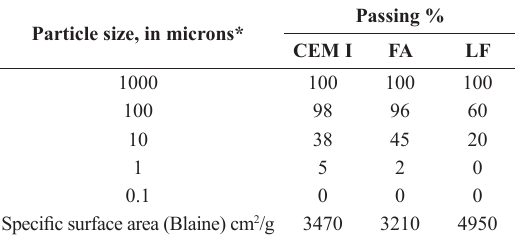
Table 2. Grading of the raw